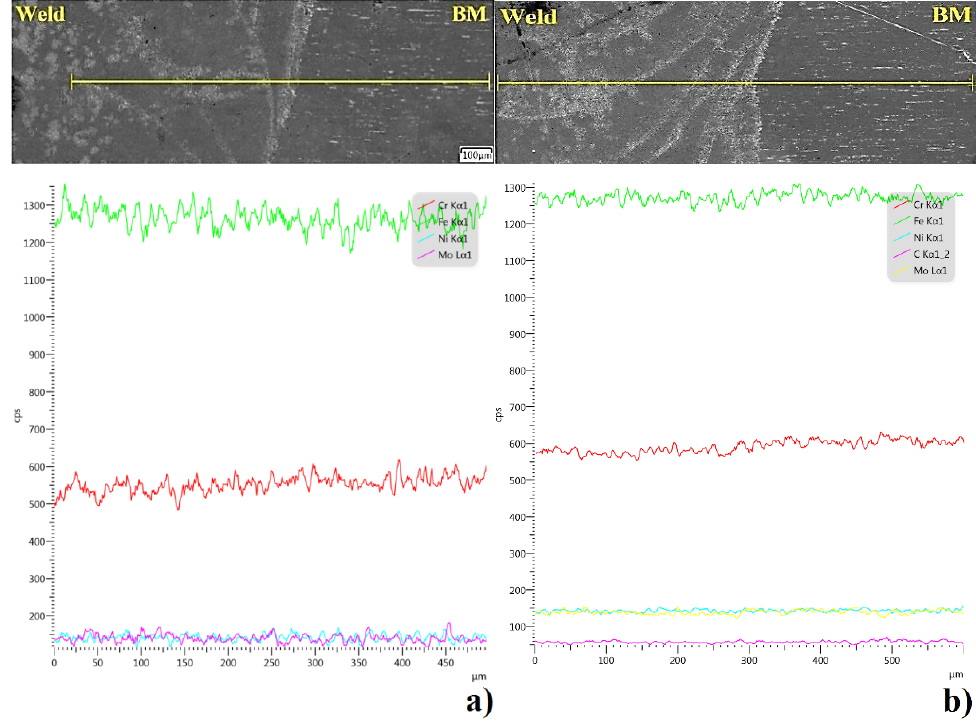
Figure 9. Linear analysis of the distribution of elements (Cr, Fe, Mo, Ni) in the weld–MR transition